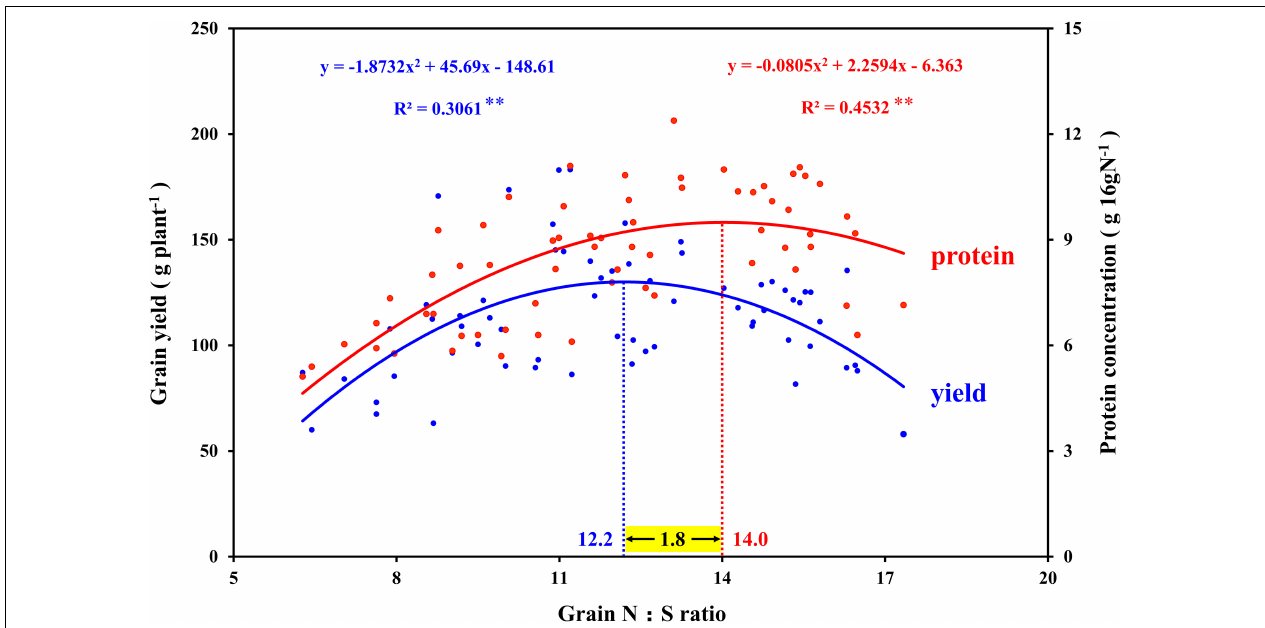
FIGURE 9 | Correlation analysis between the grain yield, grain protein concentration, and N:S ratio in maize grains. In this image, the blue curve shows the correlation between grain yield and N:S ratio in maize grains ( n = 64), and the intersection of the blue dotted line and the blue curve indicates the maximum value of the curve. The red curve shows the correlation between grain protein concentration and N:S ratio in maize grains ( n = 64), and the intersection of the red dotted line and the red curve indicates the maximum value of the